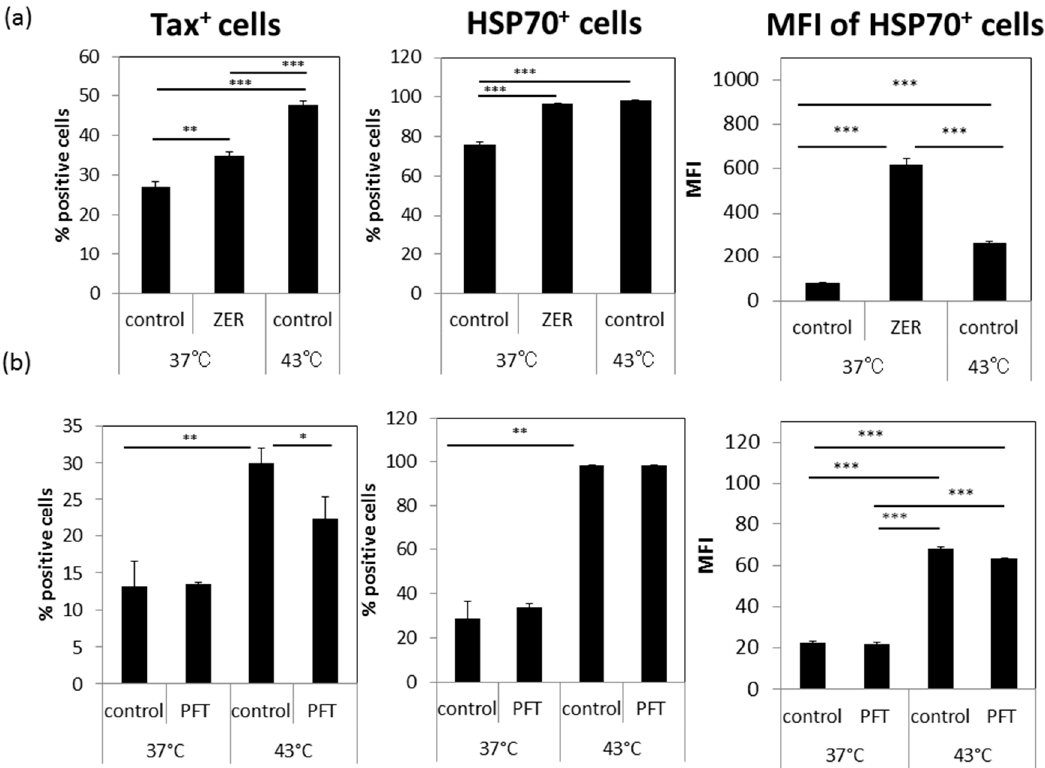
Figure 5. The effects of the HSP70 inducing and inhibiting agents on the expression of Tax antigen: Triplicate cultures of YT/cM1 cells were either exposed to HS or mock treated, and then cultured in the presence or absence of either ( a ) 10 μ M zerumbone (ZER, HSP70 inducer) or ( b ) 1 μ M pifithlin ‐μ (PFT, HSP70 functional inhibitor) for 24 h. The Tax and HSP70 expression was analyzed by FCM. The values denote the means ± SD. * p <0.05, ** p <0.01, *** p <0.001.